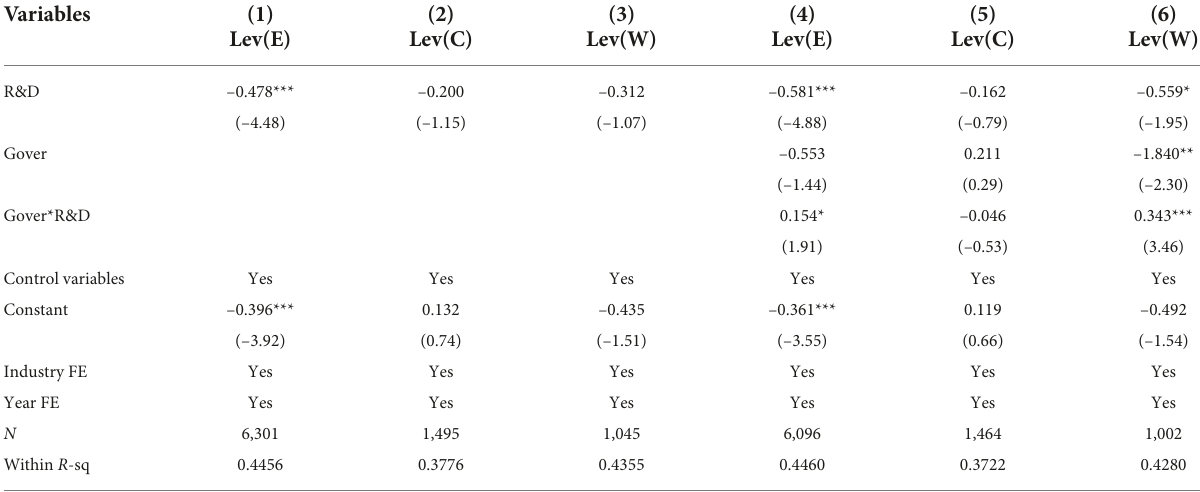
TABLE 6 A comparison of regression results on the relationship between technological innovation and corporate leverage in different regions before and after the inclusion of policy